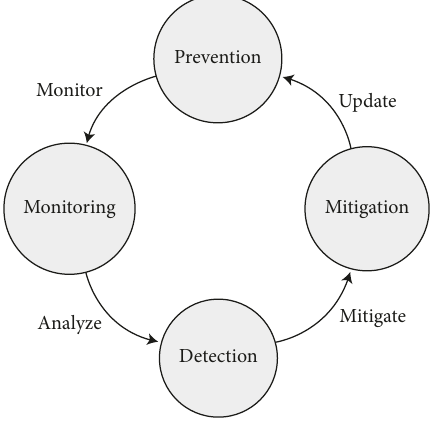
Figure 2: DDoS defence life